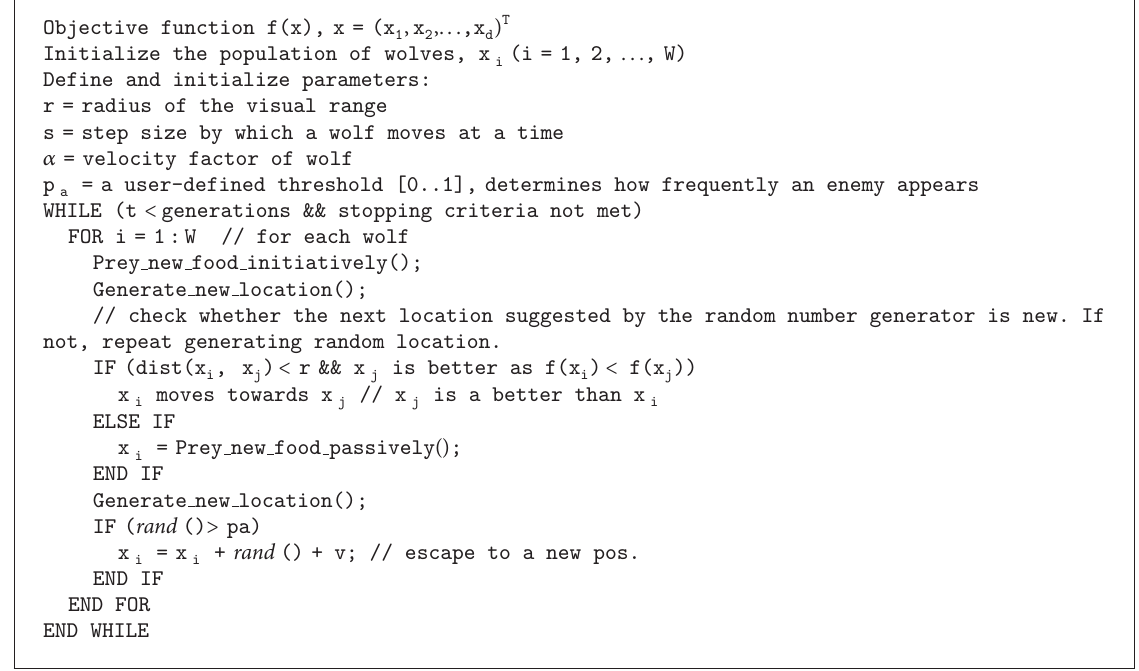
Algorithm 1: Pseudocode for the WSA